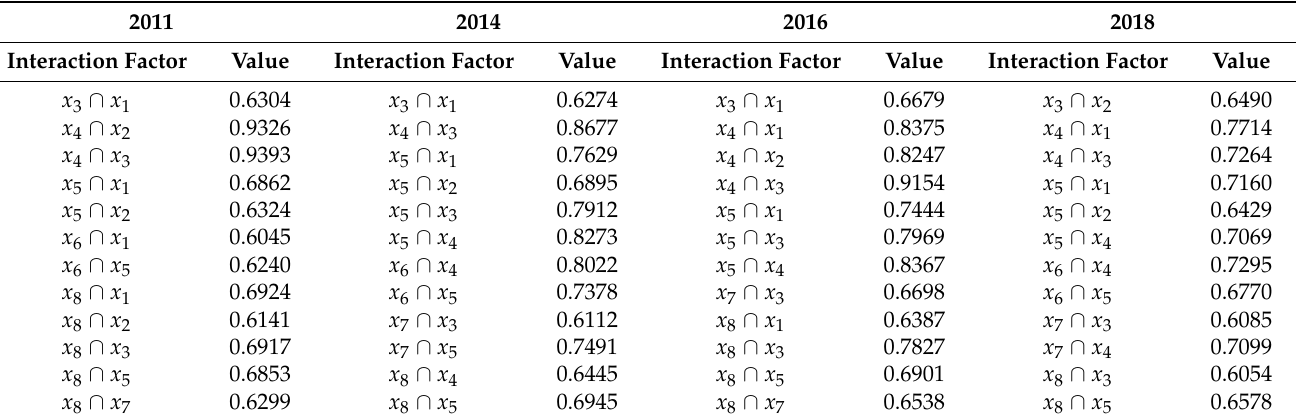
Table 5. Interaction of influencing factors on urban resilience in the